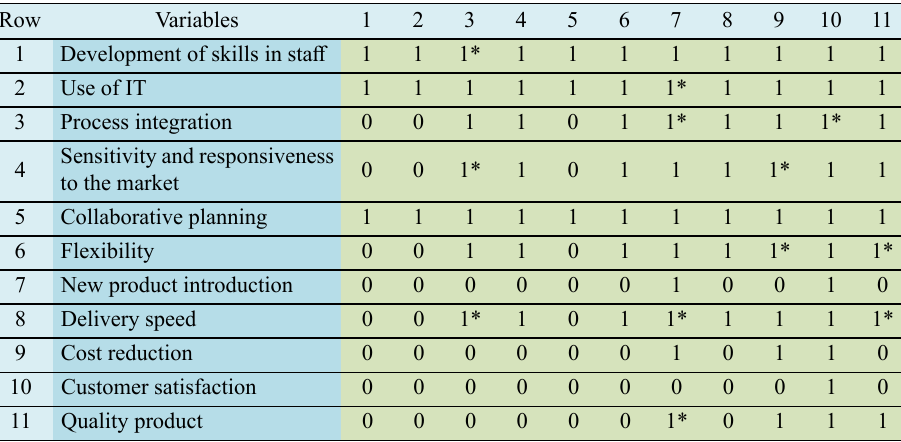
Table 5. Reachability matrix after